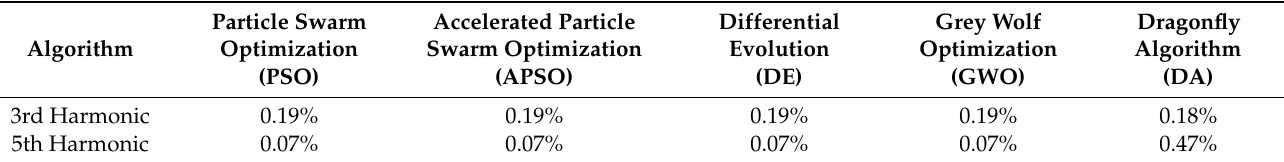
Table 2. Percentage harmonics (w.r.t. fundamental) for seven-level CHB